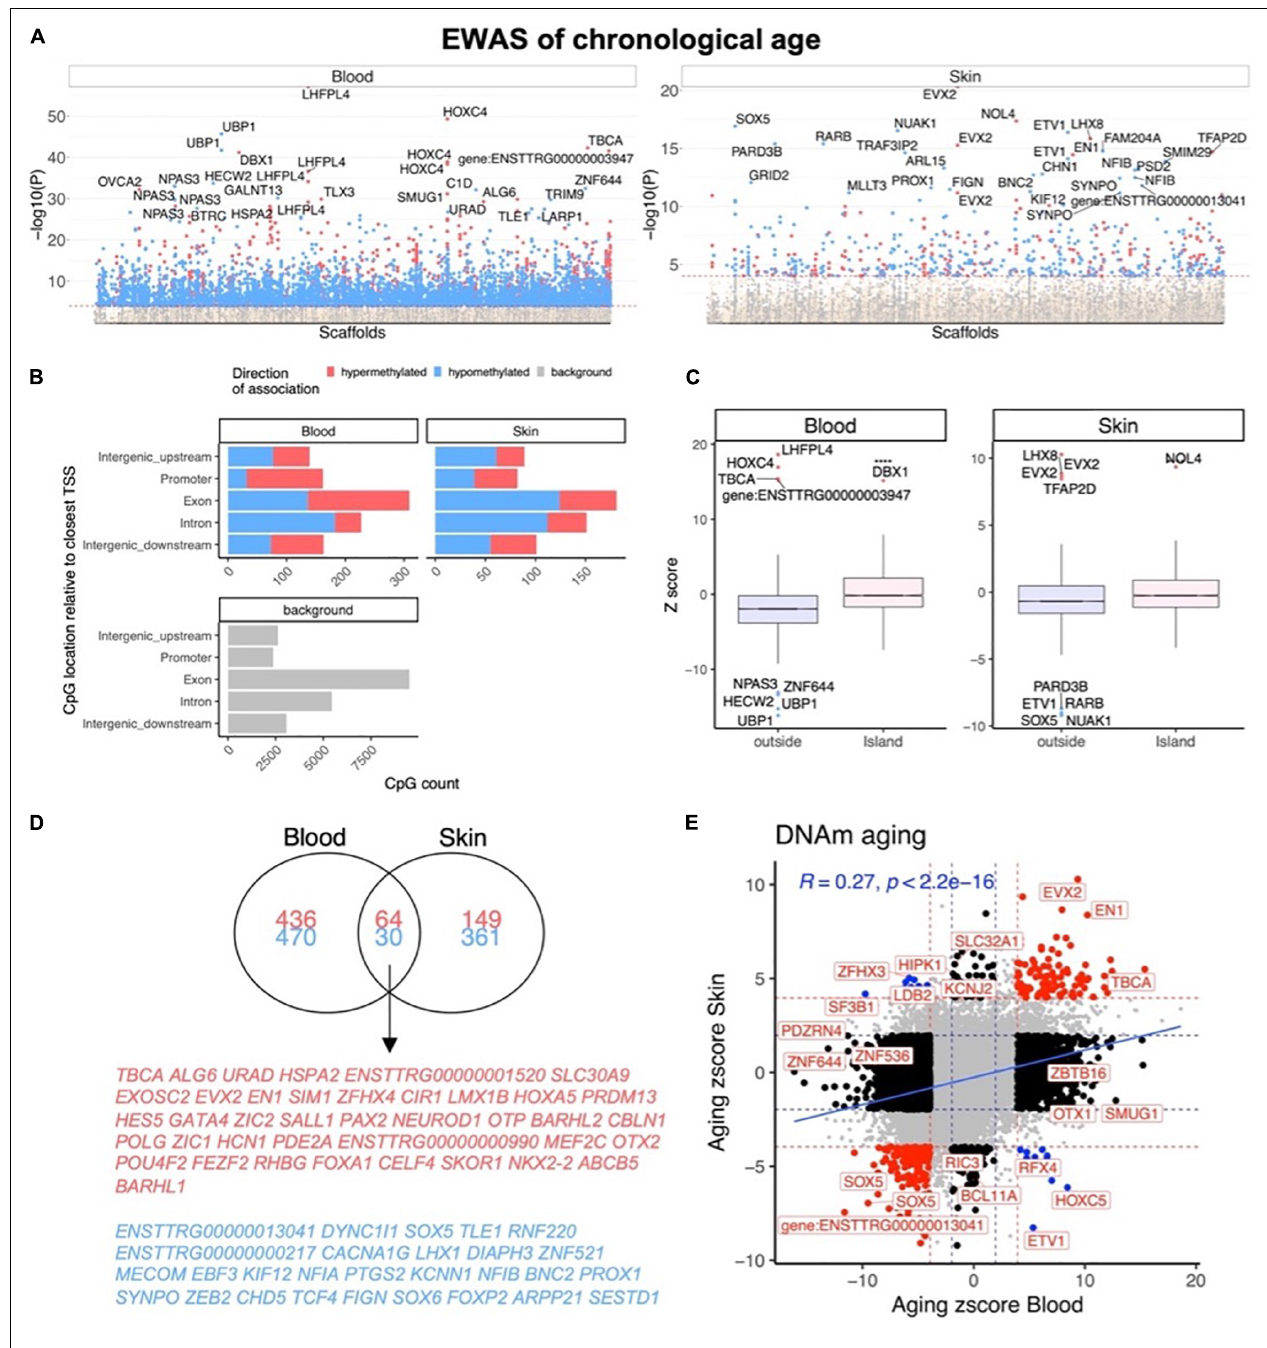
FIGURE 2 | Epigenome-wide association (EWAS) of chronological age in skin and blood of bottlenose dolphin species. (A) Manhattan plots of the EWAS of chronological age. The coordinates are estimated based on the alignment of Mammalian array probes to the bottlenose dolphin (turTru1.100) genome assembly. The direction of associations with P < 0.0001 (red dotted line) is highlighted by red (hypermethylated) and blue (hypomethylated) colors. The 30 most significant CpGs were labeled by their respective neighboring genes. (B) Genomic location analysis of significant ( P < 10 − 4 ) CpGs. The blood analysis focused on the top 500 positively age related CpGs and the top 500 negatively age related CpGs. The skin analysis focused on 213 positively and 391 negatively age related CpGs. (C) Box plot visualizing the median value (line inside the box) and the 25th and 75th percent quartiles (top and bottom of the box), and the whiskers correspond to the 90th percentile. The x -axis corresponds to CpG island status. (D) Venn diagram of the most significant age related CpGs in blood and skin. (E) Sector plot of DNA methylation aging effects in blood and skin. Each axis reports the Z statistic from a correlation test which follows a standard normal distribution under the null hypothesis. Red dotted line: P < 10 − 4 ; blue dotted line: P > 0.05; Red dots: shared CpGs; black dots: tissue specific changes; blue dots: CpGs where age correlation differs between blood and skin tissue. The gray color in the last panel represents the location of 23,005 mammalian array probes mapped to the bottlenose dolphin (turTru1.100)